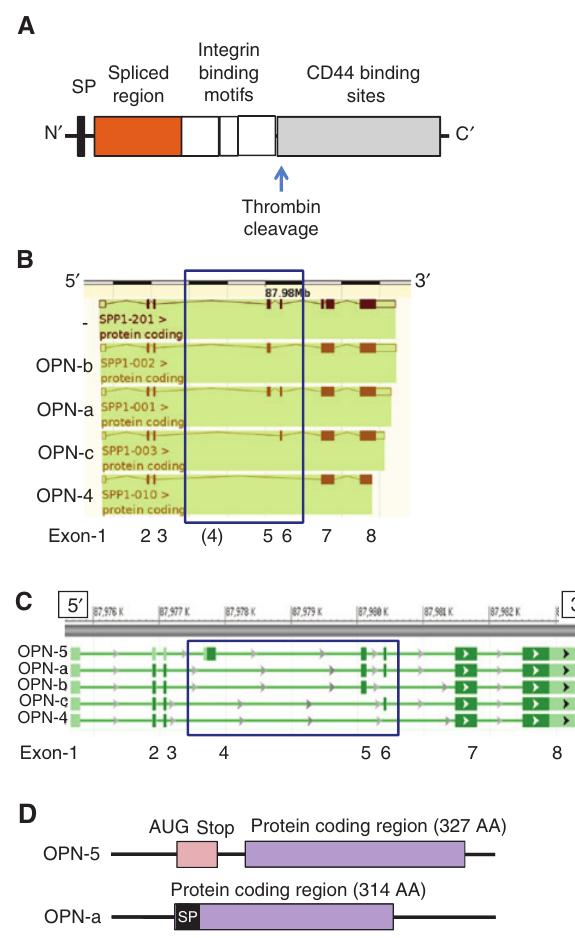
Figure 1: Alternative splicing of the human osteopontin gene ( SPP-1 ) and associated protein domains. (A) The osteopontin (OPN) protein is relatively unstructured and lacks conserved domains. Instead, the regions involved in ligand binding are indicated. Splicing affects a region in the N-terminal region of the protein following the signal peptide (SP; AA 31-72 in the OPN-a sequence), shown in orange. This region does not contain any known ligand binding domains but does include O-linked glycosylation and phosphorylation sites (26). There are also three integrin-binding motifs in the central region of the protein, plus a C-terminal region responsible for CD44 binding and containing an EF-hand calcium binding motif (63). The site of thrombin cleavage (AA 169 in the OPN-a sequence) is shown, and OPN is also cleaved by MMPs at AA 166, 201 and 210. Heparin binding sites have been identified at AA 151-160 and 276-283 (26, 63). Diagram is not to scale. (B) The ENSEMBL database identifies five protein coding alternative transcripts for the SPP-1 gene, resulting from the alterna- tive splicing of two exons (blue box). (C) The NCBI Gene database also identifies five alternative protein coding transcripts for SPP-1